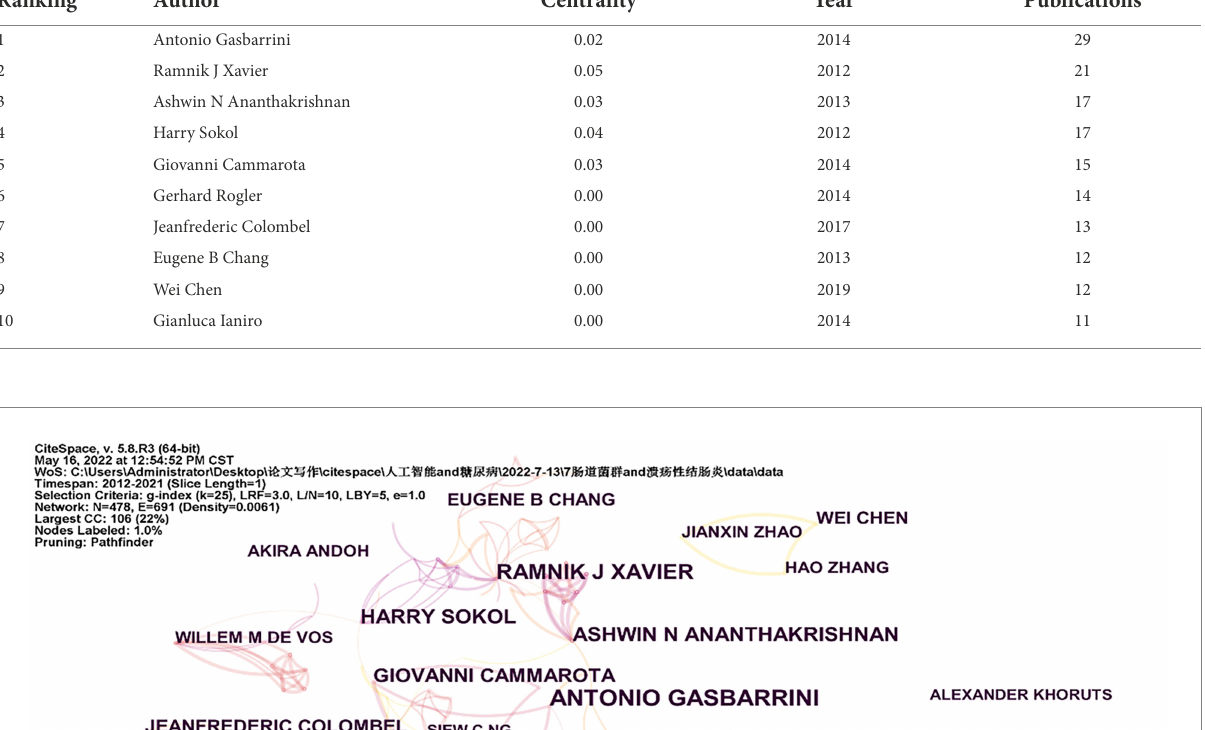
reducing bacteria.”